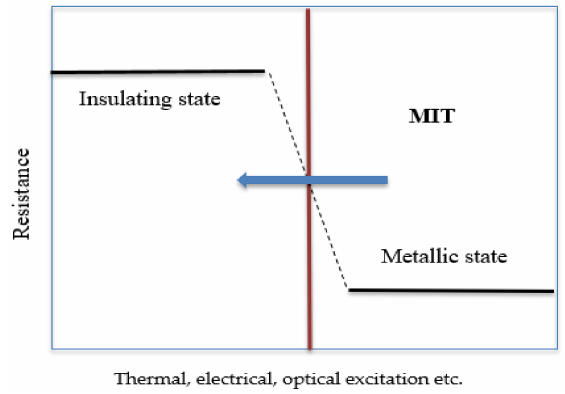
Figure 7. Typical metal-insulator transition characteristic for metal-insulator transition (MIT) materials (i.e., Vanadium